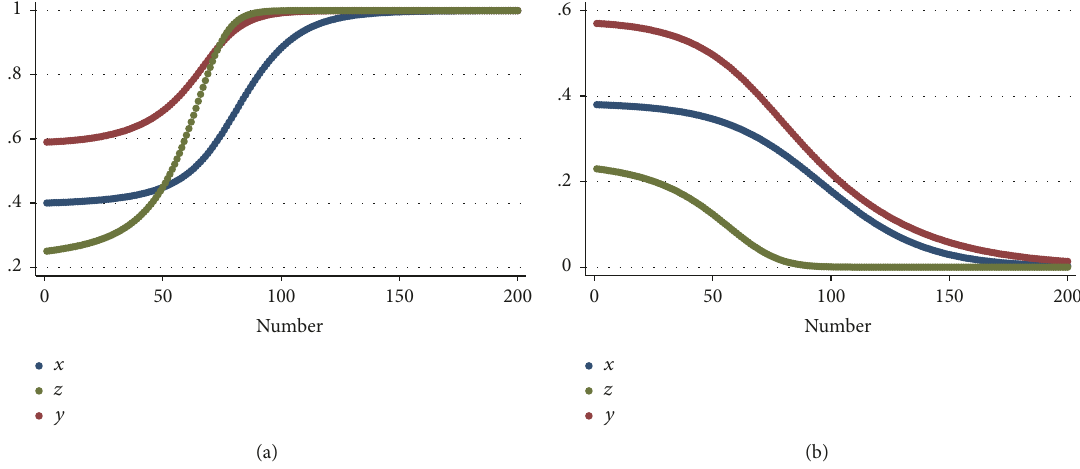
Figure 3: Simulation results when initial coordinates change.